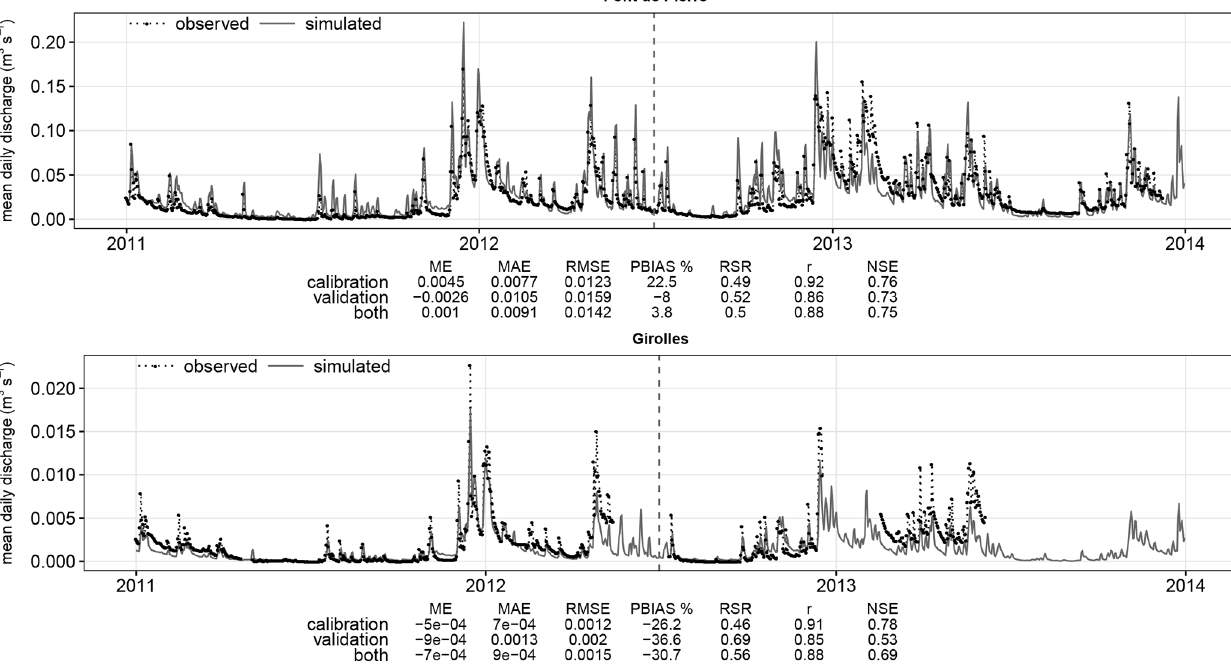
Hydrol. Earth Syst. Sci., 25, 291–319,